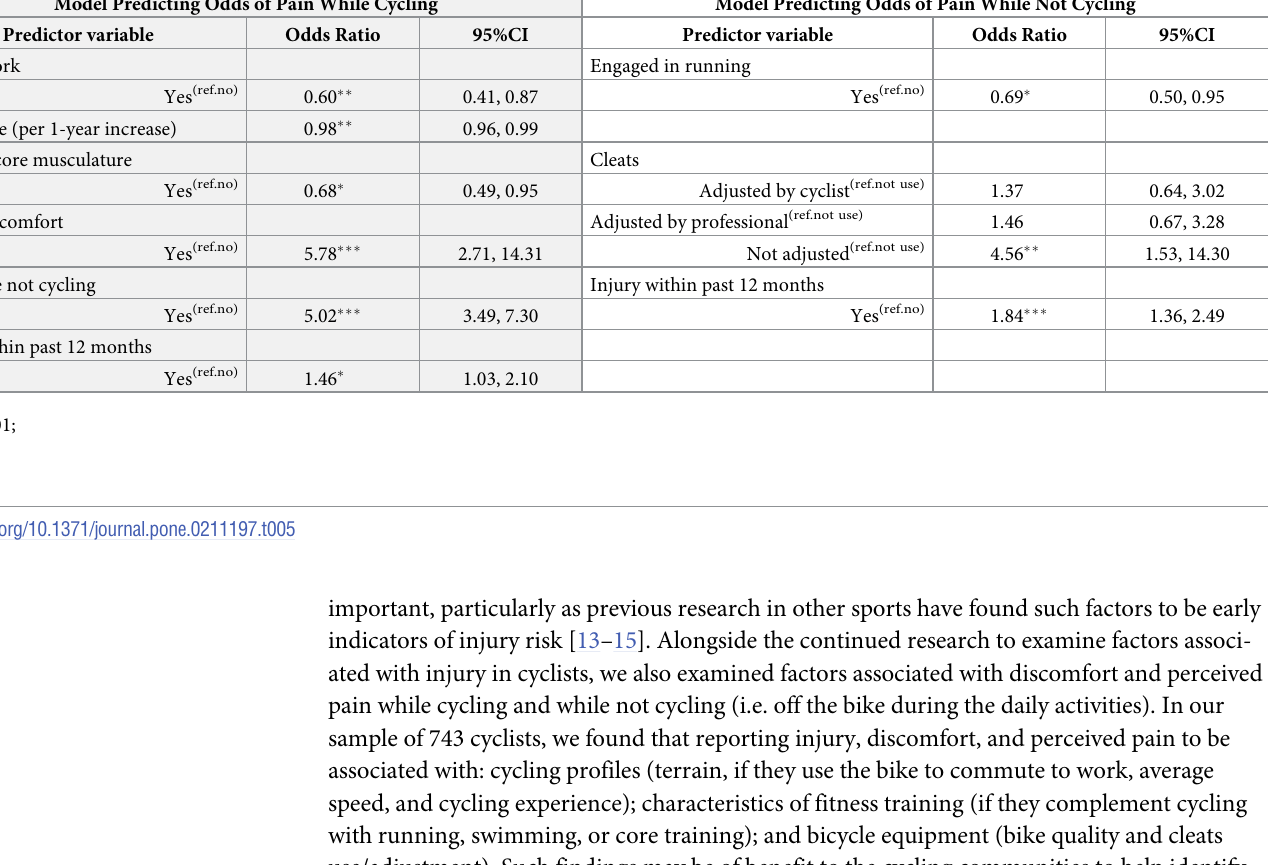
Table 5. Logistic regression models assessing the odds of reporting pain while cycling and pain while not cycling, respectively. Referent categories for models were not reporting pain. Model Predicting Odds of Pain While